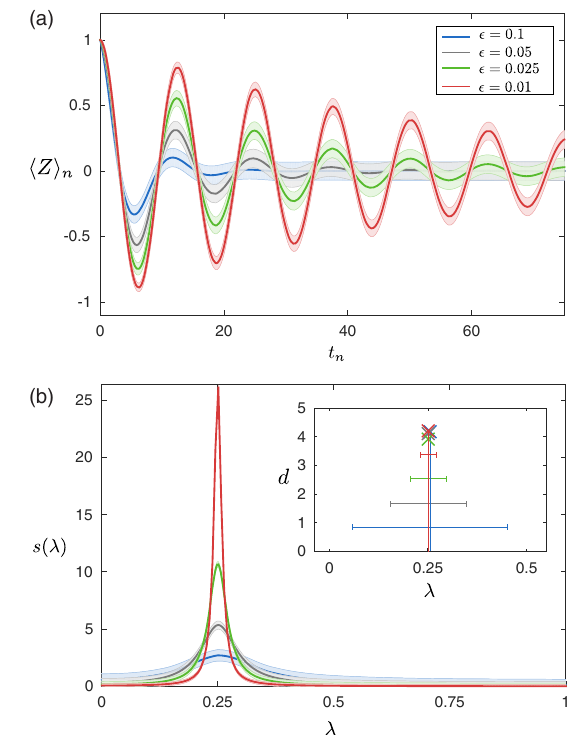
FIG. 4. Analysis of the protocol. (a) Ramsey signal as a function of the stroboscopic evolution time t n for a density operator with four degenerate eigenvalues λ α ¼ 1 = 4 ð α ¼ 1 ; … ; 4 Þ , using different sizes of the time step ϵ . The finite size of the time step leads to a damping of the signal over a time τ ∼ O ð ϵ − 1 Þ (cf. Appendix A). We indicate the measurement ffiffiffiffiffiffiffiffiffiffiffiffiffiffiffiffiffiffiffiffiffiffiffiffiffiffiffiffiffiffiffiffiffi p uncertainty due to shot noise Δ Z n ¼ for ð 1 − h Z i 2 n Þ =N shot N 200 measurements per point. (b) Fourier-transformed P shot ¼ ϵ h Z i 2 t ν Þ , with the uncertainty Ramsey signal s ð ν Þ ¼ ffiffiffiffiffiffiffiffiffiffiffiffiffiffiffiffiP p n n cos ð n Δ s ∼ ϵ Δ Z 2 . Each eigenvalue of the density operator gives n n rise to a Lorentzian whose width is determined by the size of the stroboscopic step. The product of the height and the width of the peak reveals that it stems from d ¼ 4 eigenvalues at λ ¼ 0 . 25 . This is depicted in the inset by the circles, where the horizontal bars correspond to the width of the peak and indicate the spectral resolution. To observe the signature of the fourfold degeneracy, ∼ 150 copies are necessary ( ϵ ¼ 0 . 1 ). The position around n max of the maximum, together with the height and the width of the resonance, allows one to determine the weight of the peak, i.e., the degeneracy ( d ) of the corresponding eigenvalue (see text). The inset shows the position of the resonance and its degeneracy d for the peak at λ ≈ 0 . 25 for the different values of ϵ ¼ 0 . 1 , 0.05, 0.025, 0.01. In all cases, one finds d ∼ 4 , as expected for fourfold degenerate eigenvalues. The horizontal bar indicates the width of the peak, σ α